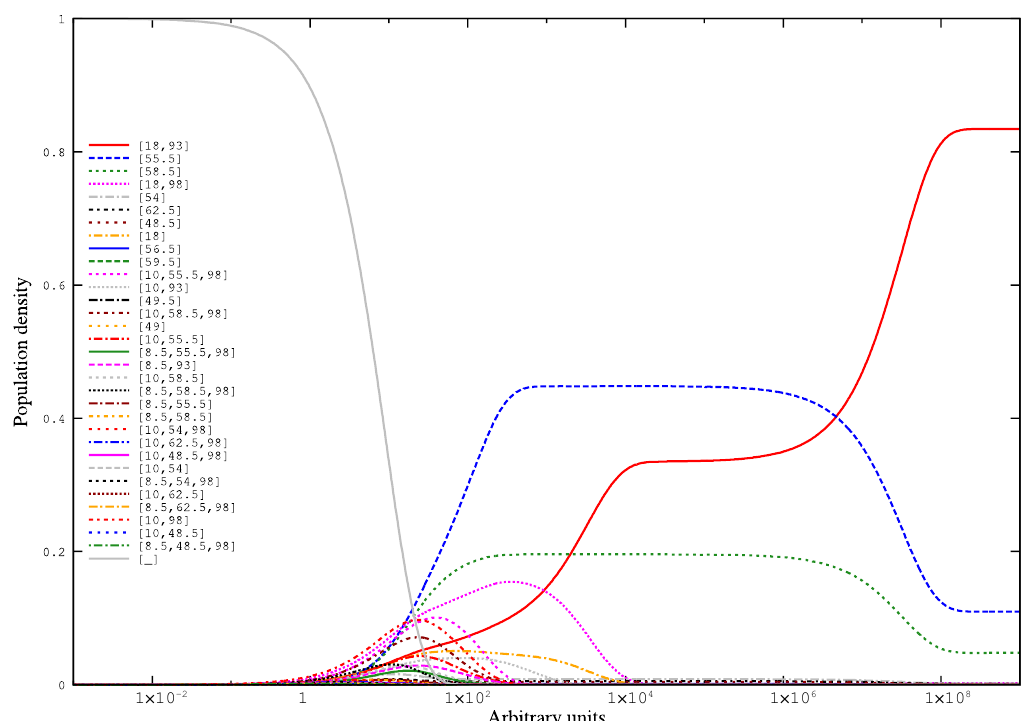
Figure 5. Folding kinetics of the trp -attenuator alignment simulated with RNA LI H I K INETICS . The simulation was based on all strictly negative π h hishapes plus the open chain ([_]), which was used as the starting structure for this